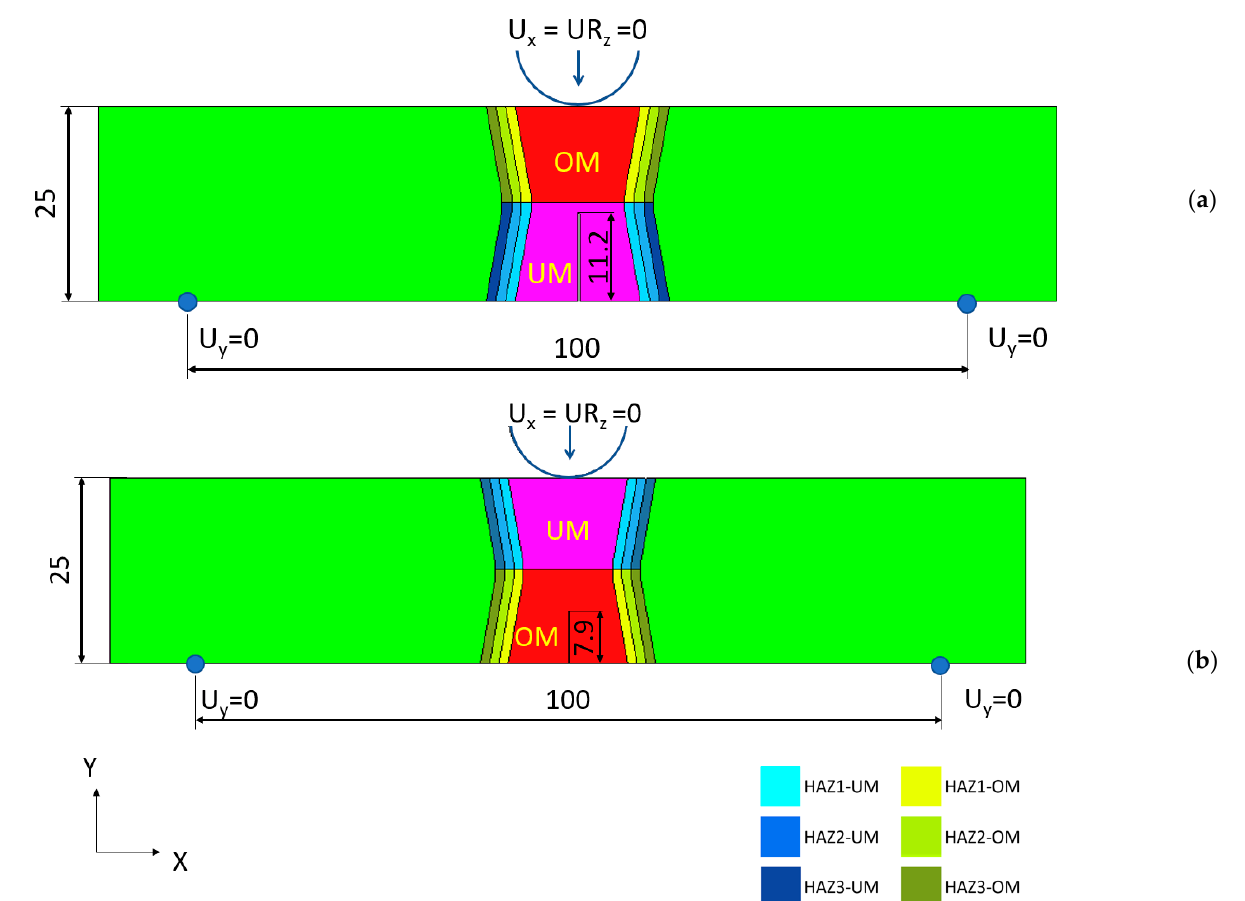
Figure 5. Schematic view on model for FEM with partition for each material enrolled in analysis: ( a ) UM/OM configuration 1 (initial crack in UM); ( b ) OM/UM configuration 2 (initial crack in OM).